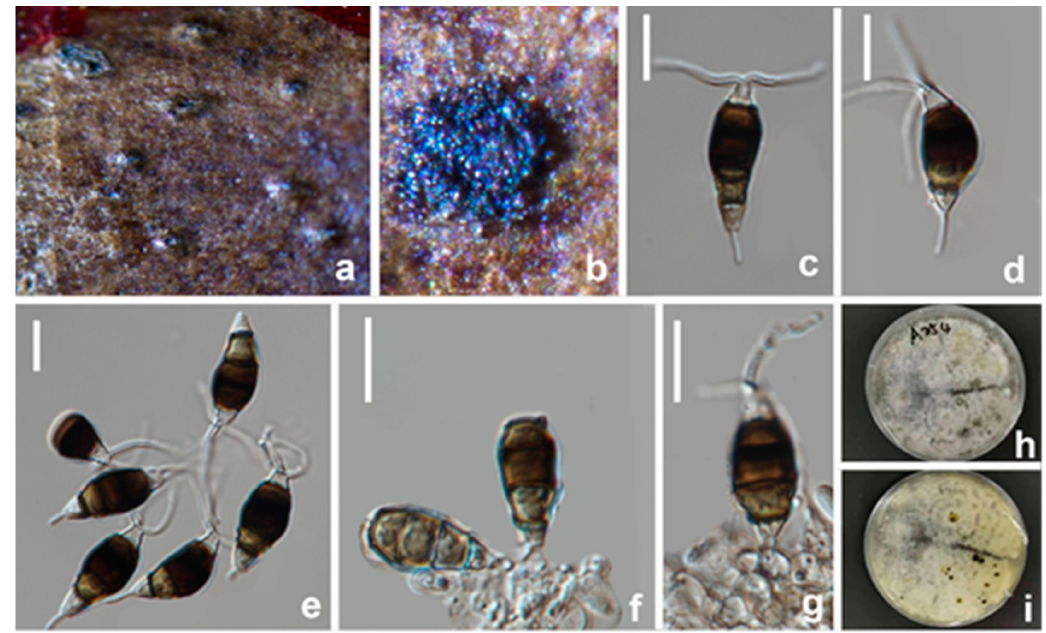
Figure 8. Neopestalotiopsis terricola (HKAS 123213, holotype) ( a , b ) Appearance of conidiomata on the host. ( c – e ) Conidia. ( f , g ) Conidiogenous cells and conidia. ( h , i ) Upper and reverse view of the colony on PDA. Scale bars: ( c – g ) = 10 μ m.